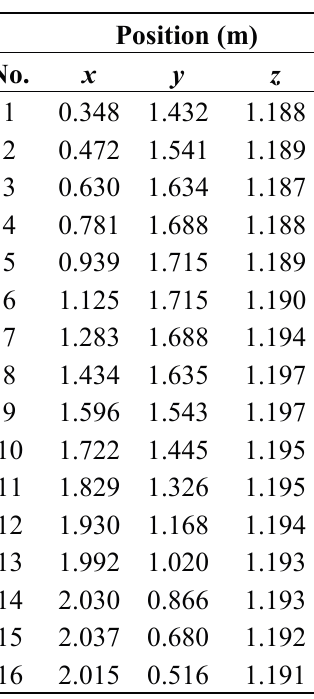
Figure 12. Surveying of calibration targets by a total station. Table 2. Positions and standard deviations of the horizontal